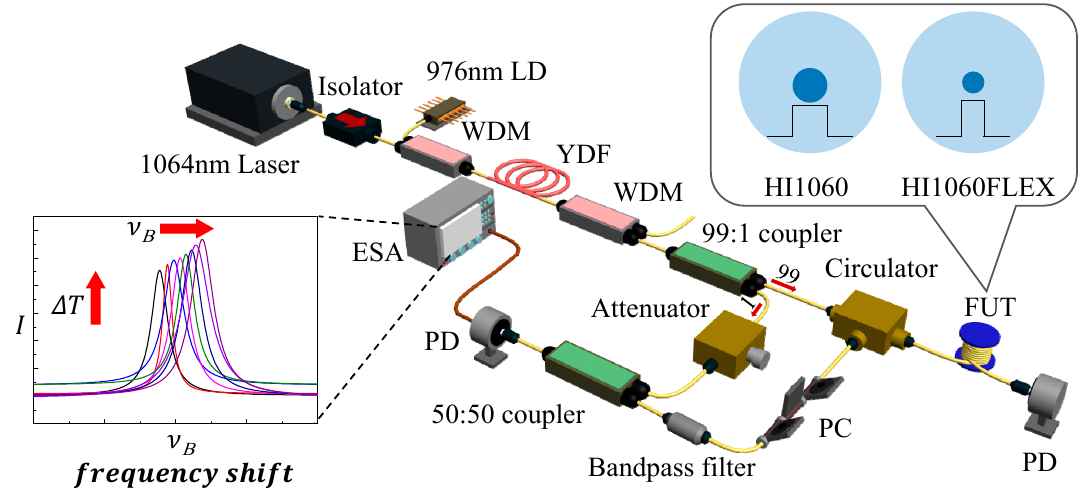
Figure 1. Schematic diagram of the all-fiber optical heterodyne SBS measurement set-up for passive 1060 nm single mode fibers (SMFs) (Corning HI1060, HI1060Flex) (YDF: Yb-doped fiber; WDM: wavelength division multiplexer; LD: laser diode; PD: photodetector; PC: polarization controller; FUT: fiber under test; ESA: electric spectrum analyzer).